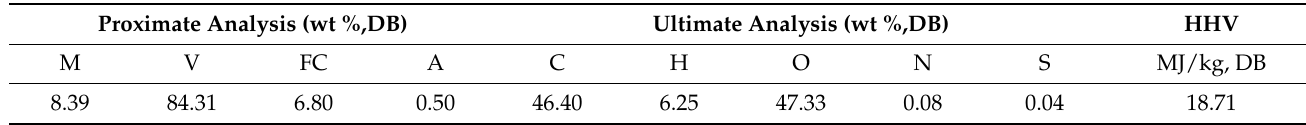
Table 1. Proximate and ultimate analyses of the raw samples.